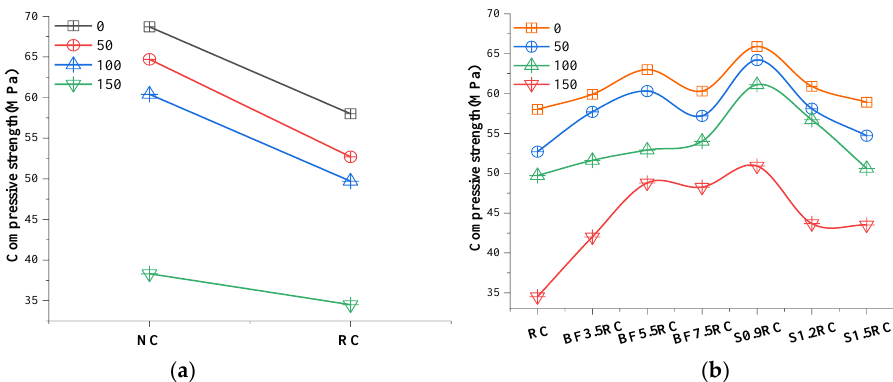
Figure 6. Change in compressive strength during the freeze – thaw period. ( a ) Ordinary and recycled concrete. ( b ) Fiber-only recycled concrete.